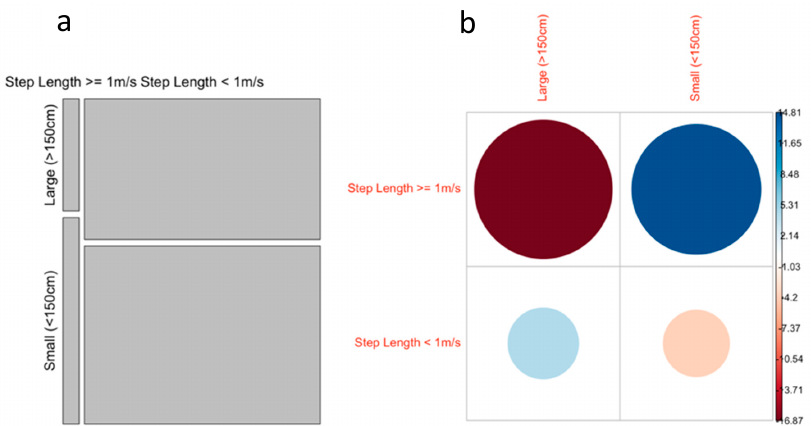
Figure 8. ( a ) A mosaic plot comparing proportions of step length above and below 1 m/s according to size of the ray measured by disc width. The ‘x’ axis compares the proportions of the total number of step lengths above and below 1 m/s for rays of all sizes. The ‘y’ axis compares the proportion of total number of step lengths above and below 1 m/s for each size class. ( b ) A balloon plot indicating the relationship between proportions of step length above and below 1 m/s according to body size. The larger the circle and darker the color, the greater the residuals and the stronger the correlation. Blue represents a positive correlation, while red represents a negative correlation.